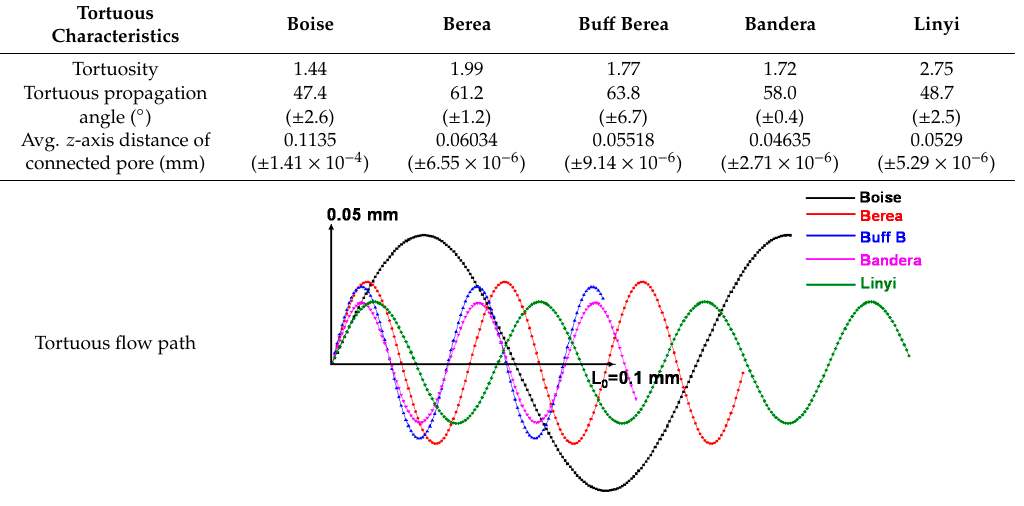
Table 4. Tortuosity of each sandstone and tortuous flow paths expressed by a sine curve.